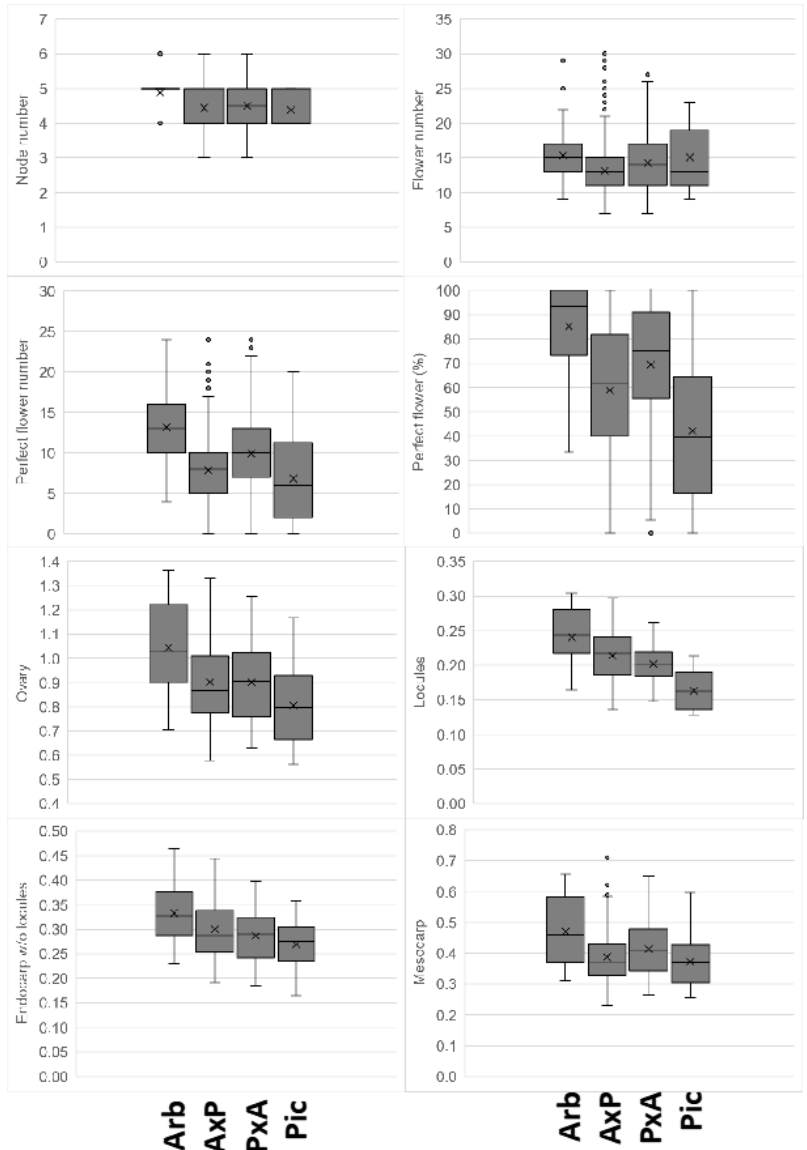
Figure 1. Flower quality parameter boxplots for ‘Arbequina’ (Arb) and ‘Picual’ (Pic) and eight seedlings of each of their reciprocal crosses (A × P and P × A). Horizontal box lines indicate the 25th, 50th, and 75th percentiles; whiskers indicate range, excluding outliers (points). Table 2. Variance components in ANOVA for the different inflorescence and ovary parameters in the sixteen seedlings and two parents (‘Picual’ and‘Arbequina’). Significant differences at p < 0.01 were obtained for all factors (genotype, year, and genotype × year) and traits.